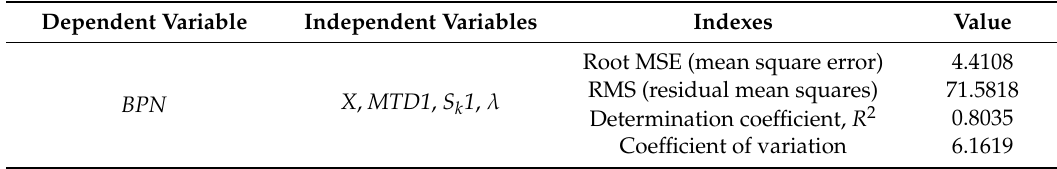
Table 3. Summary results of final BPN model.